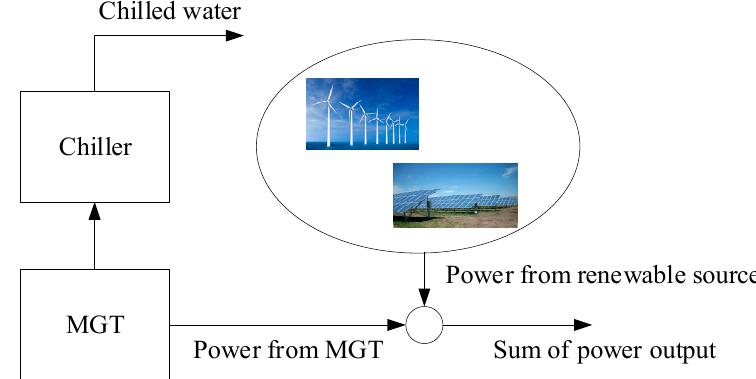
Figure 15. The block diagram of the MGT-CCP system connected to renewable energy.